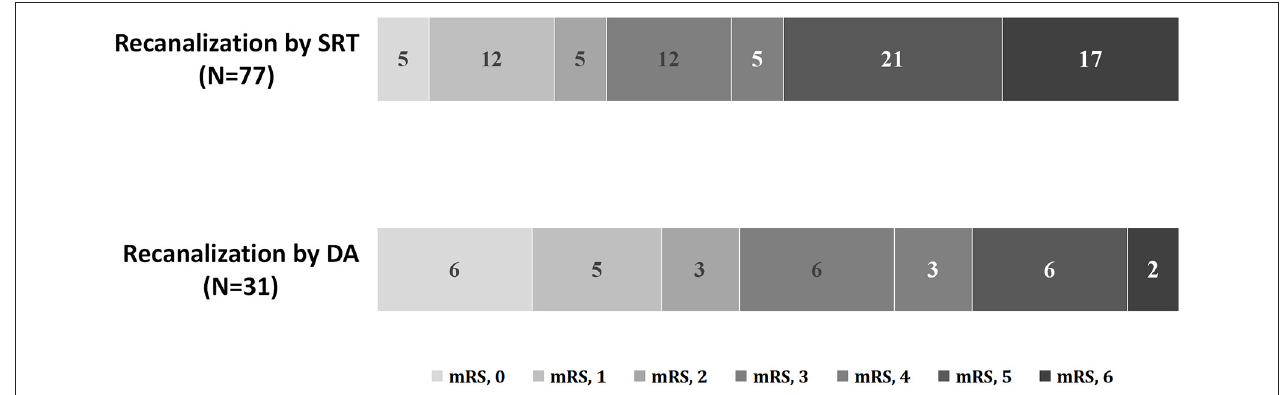
FIGURE 4 | Distribution of 90-day mRS scores of patients with ICAD-related BAO. mRS, modified Rankin Scale; BAO, basilar artery occlusion; ICAD, intracranial atherosclerotic